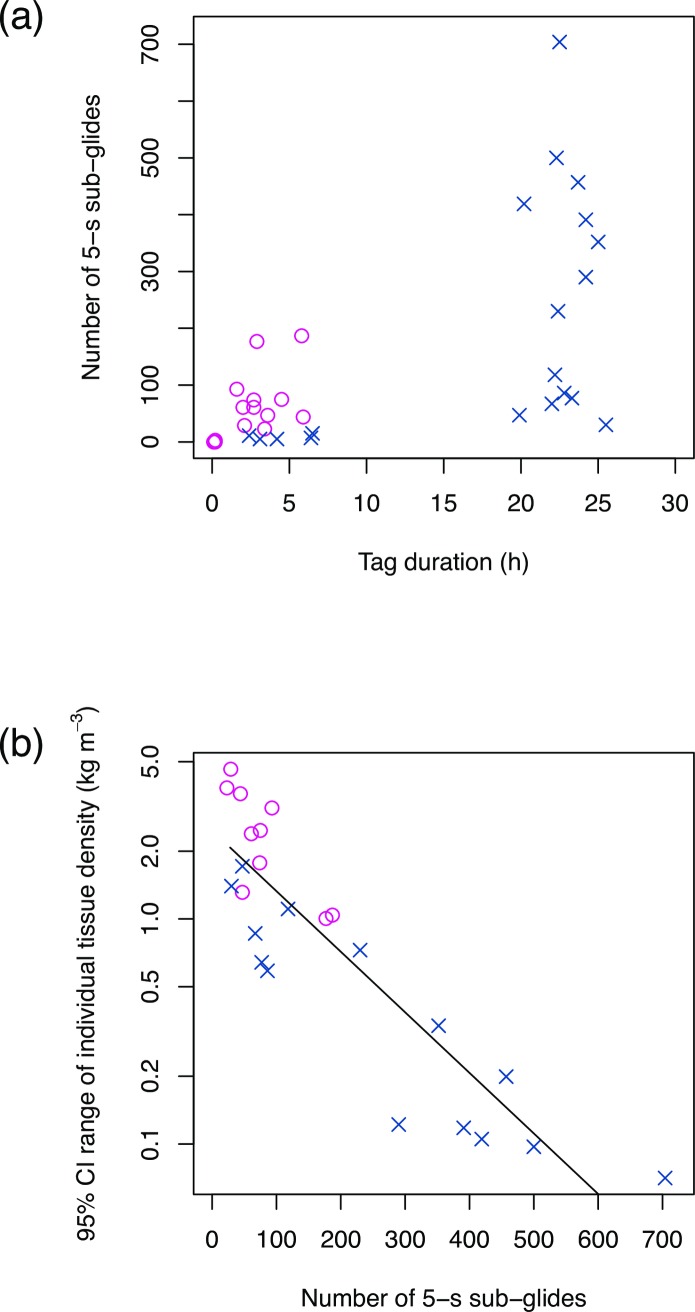
The number of 5-s sub-glides in relation to tag duration and 95% CI range.Number of 5-s sub-glides that could be used for the hydrodynamic glide model in relation to tag duration (a) and the range of 95% credible interval for tissue density estimates (b). Magenta circles and blue crosses indicate data from Gulf of St Lawrence and Antarctica, respectively. A solid line shows a regression line: log(y) = -0.0062x + 0.90.